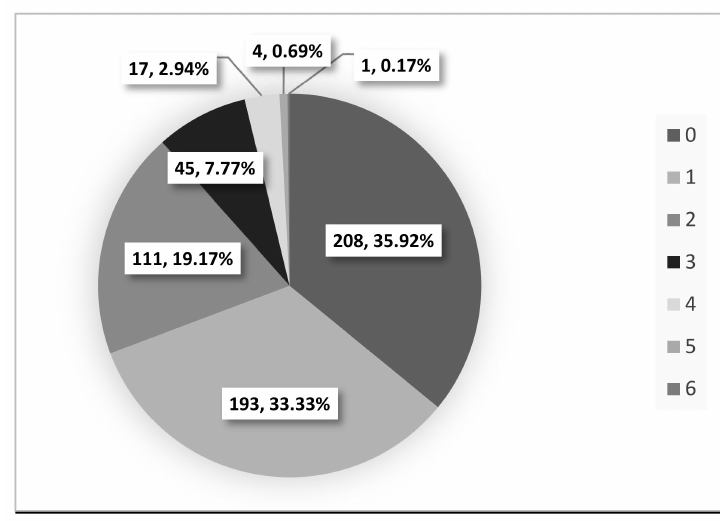
Figure 7. The number of papers by the software used. Table 8 highlights the six most used software